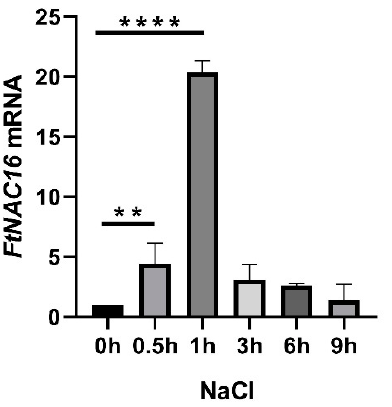
Figure 3. Relative expression of the FtNAC16 transcript in F. tataricum subjected to salt stress. The relative expression of the FtNAC16 transcript in F. tataricum was determined by means of qRT- PCR. Two-week-old seedlings were used to extract mRNA following treatment with 200 mM NaCl for 9 h. The sampling times were 0, 0.5, 1, 3, 6 and 9 h. The error bars indicate the standard error (SE) of three replicates. ** p <0.01, **** p